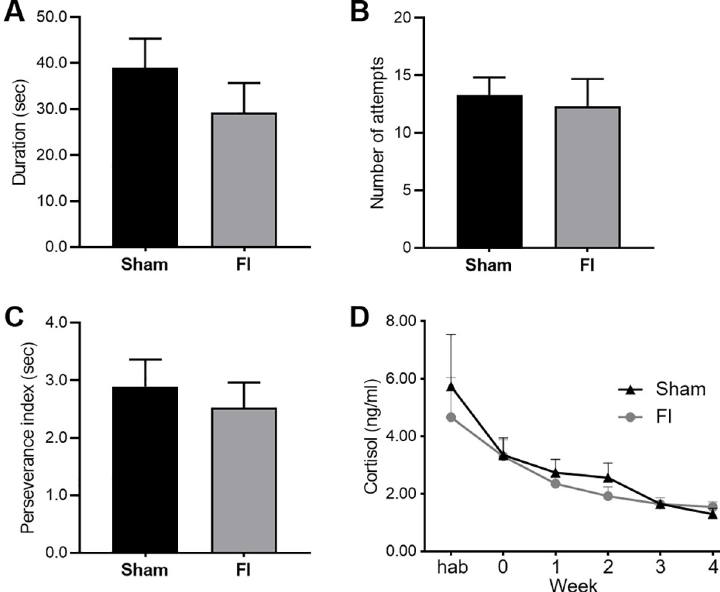
Fig 3. Behaviour and salivary cortisol evolution (SHAM, n = 10 and FI, n = 10). There was no difference of (A) duration of mobility, (B) number of attempts to escape, and (C) perseverance index between the control (Sham) and supplemented (FI) groups during the restraint test (animal number due to missing value: Sham, n = 10; FI, n = 9). The cortisol levels (D) did not differ between both groups along time (animal number due to missing value: Week hab: Sham, n = 8; FI, n = 8, Week 0: Sham, n = 9; FI, n = 10, Week 1: Sham, n = 10; FI, n = 10, Week 2: Sham, n = 10; FI, n = 10, Week 3: Sham, n = 9; FI, n = 10, Week 4: Sham, n = 10; FI, n = 10; mean +/- SEM, one-way ANOVA) although cortisol significantly decreased over time in both groups (p < 0.001, repeated-measures ANOVA).